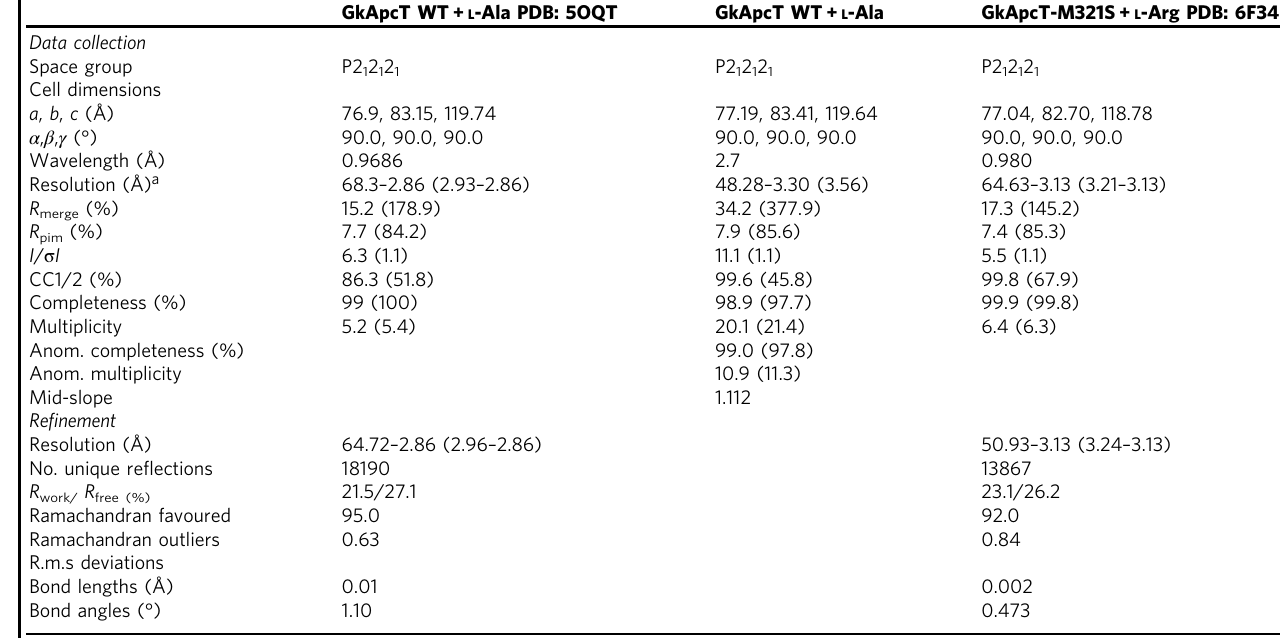
Table 1 Data collection and re fi nement statistics for